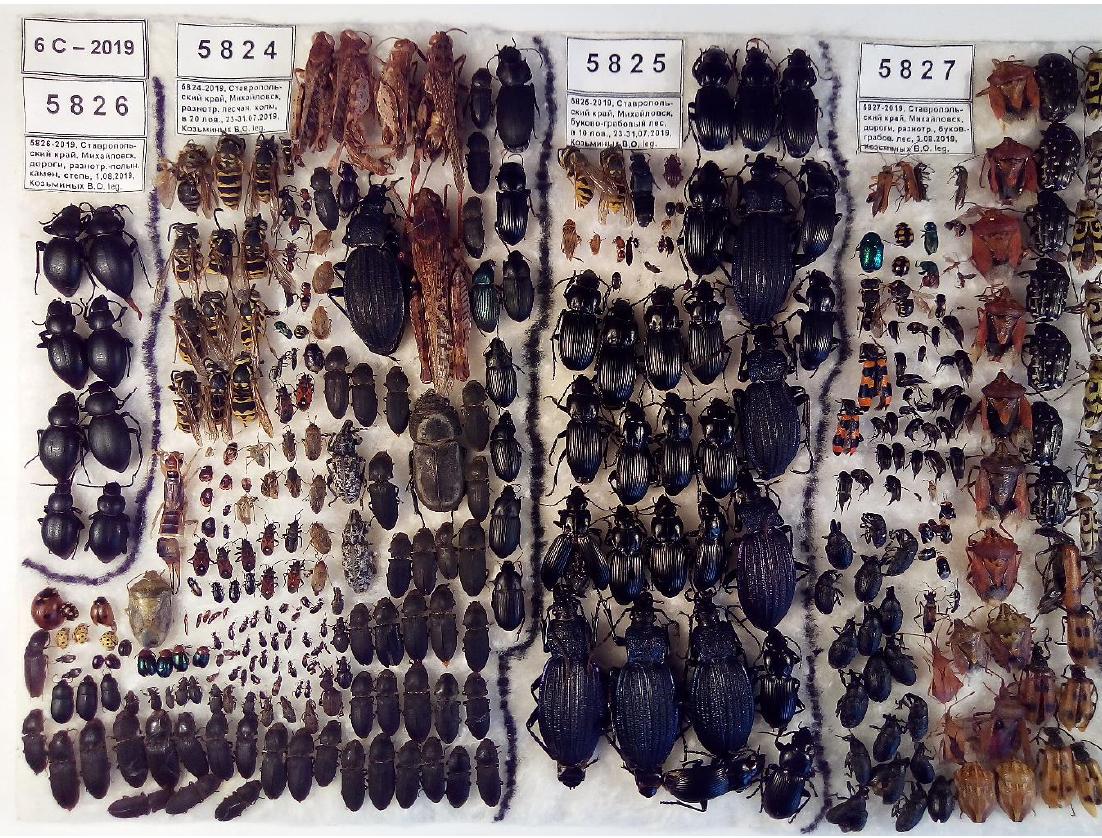
Рис. 3. Размещение сборов насекомых на ватном матрасике, г. Михайловск, 2019 г. Часть серии Compsolacon crenicollis – см. № 5824 (фотография Козьминых